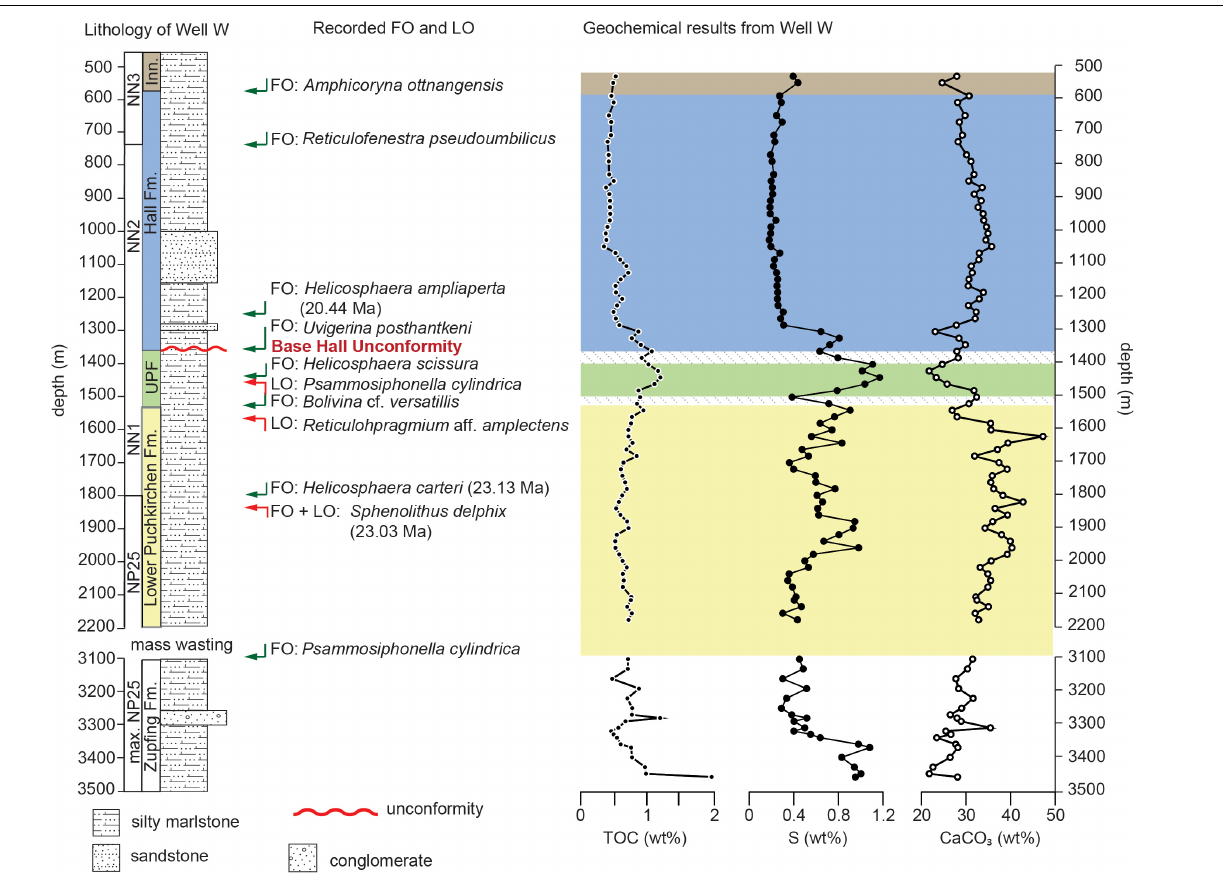
FIGURE 6 | Simplified lithological section of Well W (for position see Figure 1 ) with FO and LO of index taxa (nannofossils and benthic foraminifera), above 3200 m TOC- and S-values decrease compared to the underlying section and TOC-values show low variance, while S-values fluctuate heavily, until 1600m, the CaCO 3 -content steadily rises. The UPF shows higher S and slightly higher TOC and greatly decreased CaCO 3 -values. In the HFM, after 1300 m, TOC- and S-values drop to very low and stable levels, while CaCO 3 increases. Uncertainties are due to sampling resolution and preservation. See text for